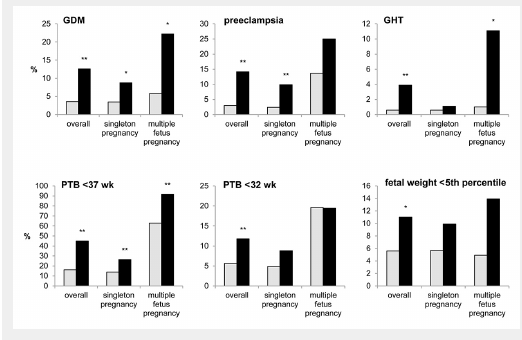
Incidence (%) of adverse maternal and infant outcome in very advanced maternal age (VAMA) patients (black) and 30-year-old patients (grey) within the overall group and within subgroups (singleton and multiple-fetus pregnancies). GDM = gestational diabetes mellitus; GHT =: gestational hypertension; PTB = preterm birth; wk = weeks of gestation ** p<0.01, * p<0.05 (chi-square